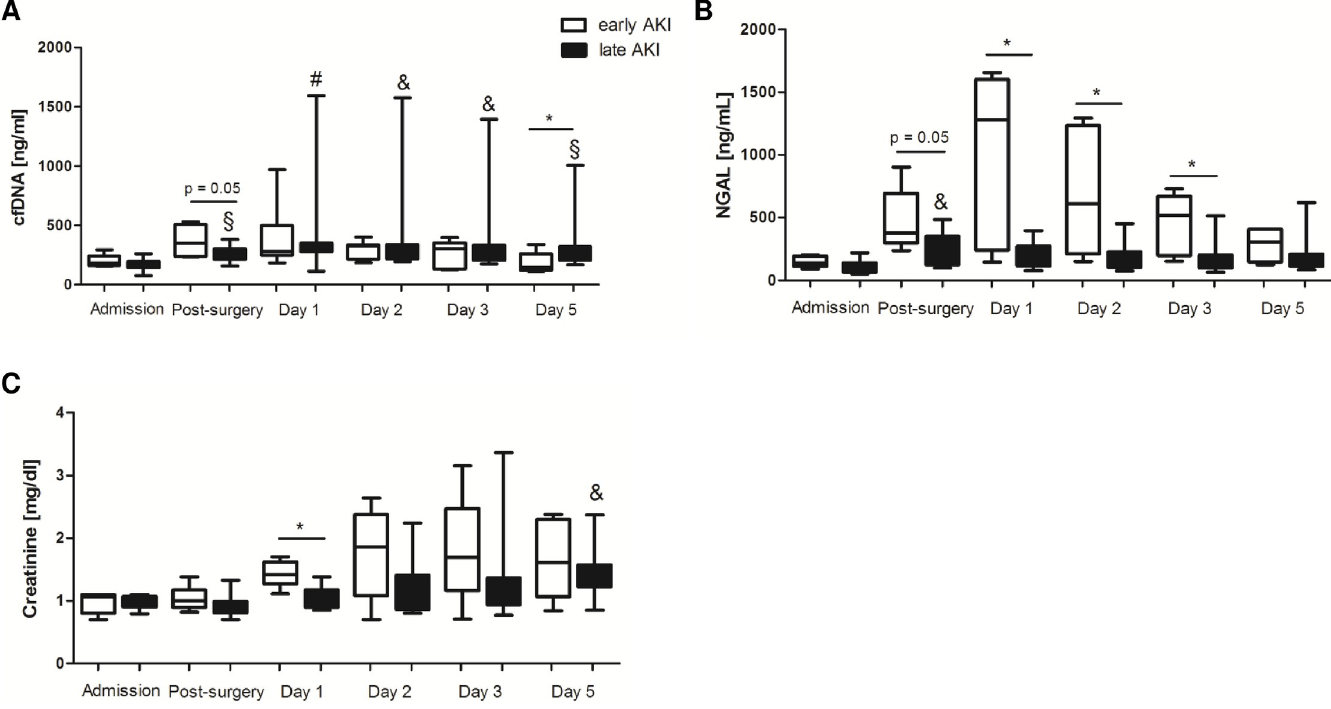
Fig 3. Kinetics of cfDNA/NETs, NGAL and creatinine in patients with early and late postoperative AKI development. AKI patients were divided into those with diagnosed AKI during the first 24 hours after surgery (early AKI) and those with AKI development at later times (late AKI). cfDNA (A), NGAL (B) and creatinine (C) concentrations were quantified at the defined times. &p < 0.05, §p < 0.01, #p < 0.001 vs. admission; � p < 0.05.